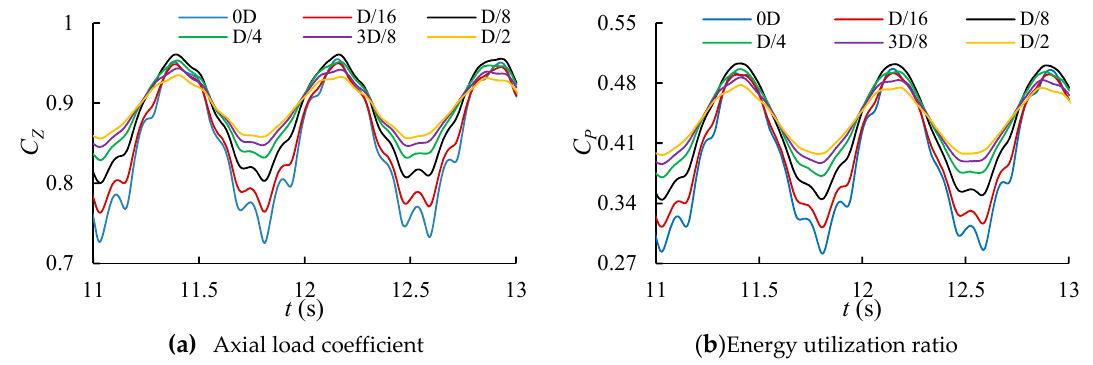
Figure 6. Time history curves of different tip-immersion.